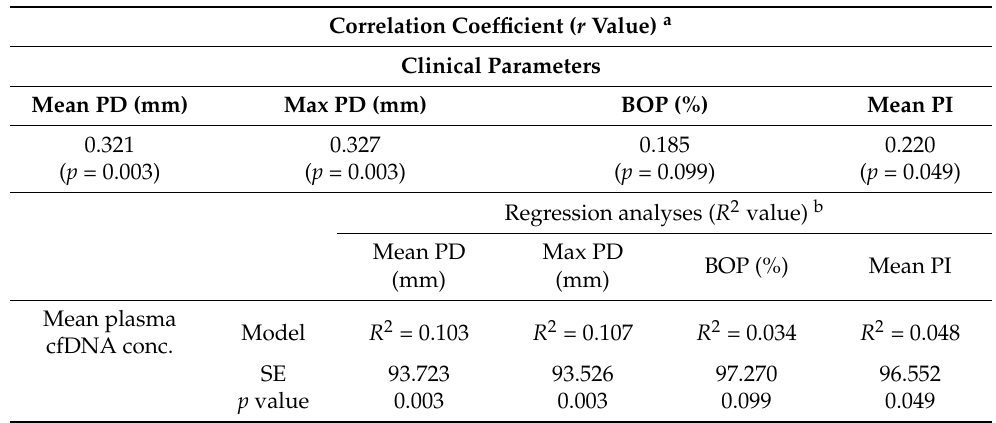
Table 4. Correlations between plasma cfDNA concentration and clinical